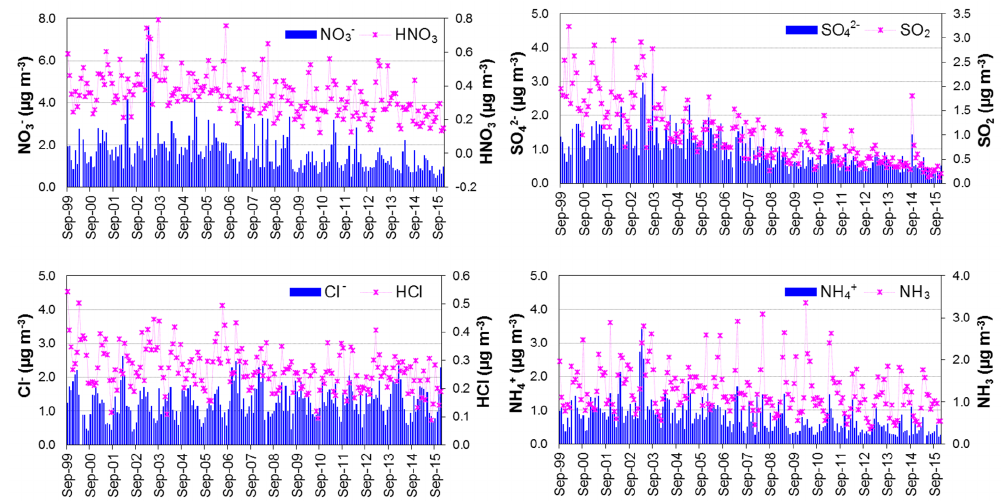
Figure 10. Monthly mean concentrations in gaseous HNO 3 , SO 2 , HCl and aerosol NO − Monitoring Network (AGANet). Monthly mean concentrations of NH 3 and NH + Ammonia Monitoring Network (NAMN, Tang et al., 2018) are also shown for comparison. Each data point in the graphs represents the mean of monthly measurements of 12 sites operational in the network over the period September 1999 to December 2015. The same plots for the full 30 site network from 2006 to 2015 are shown in Fig.